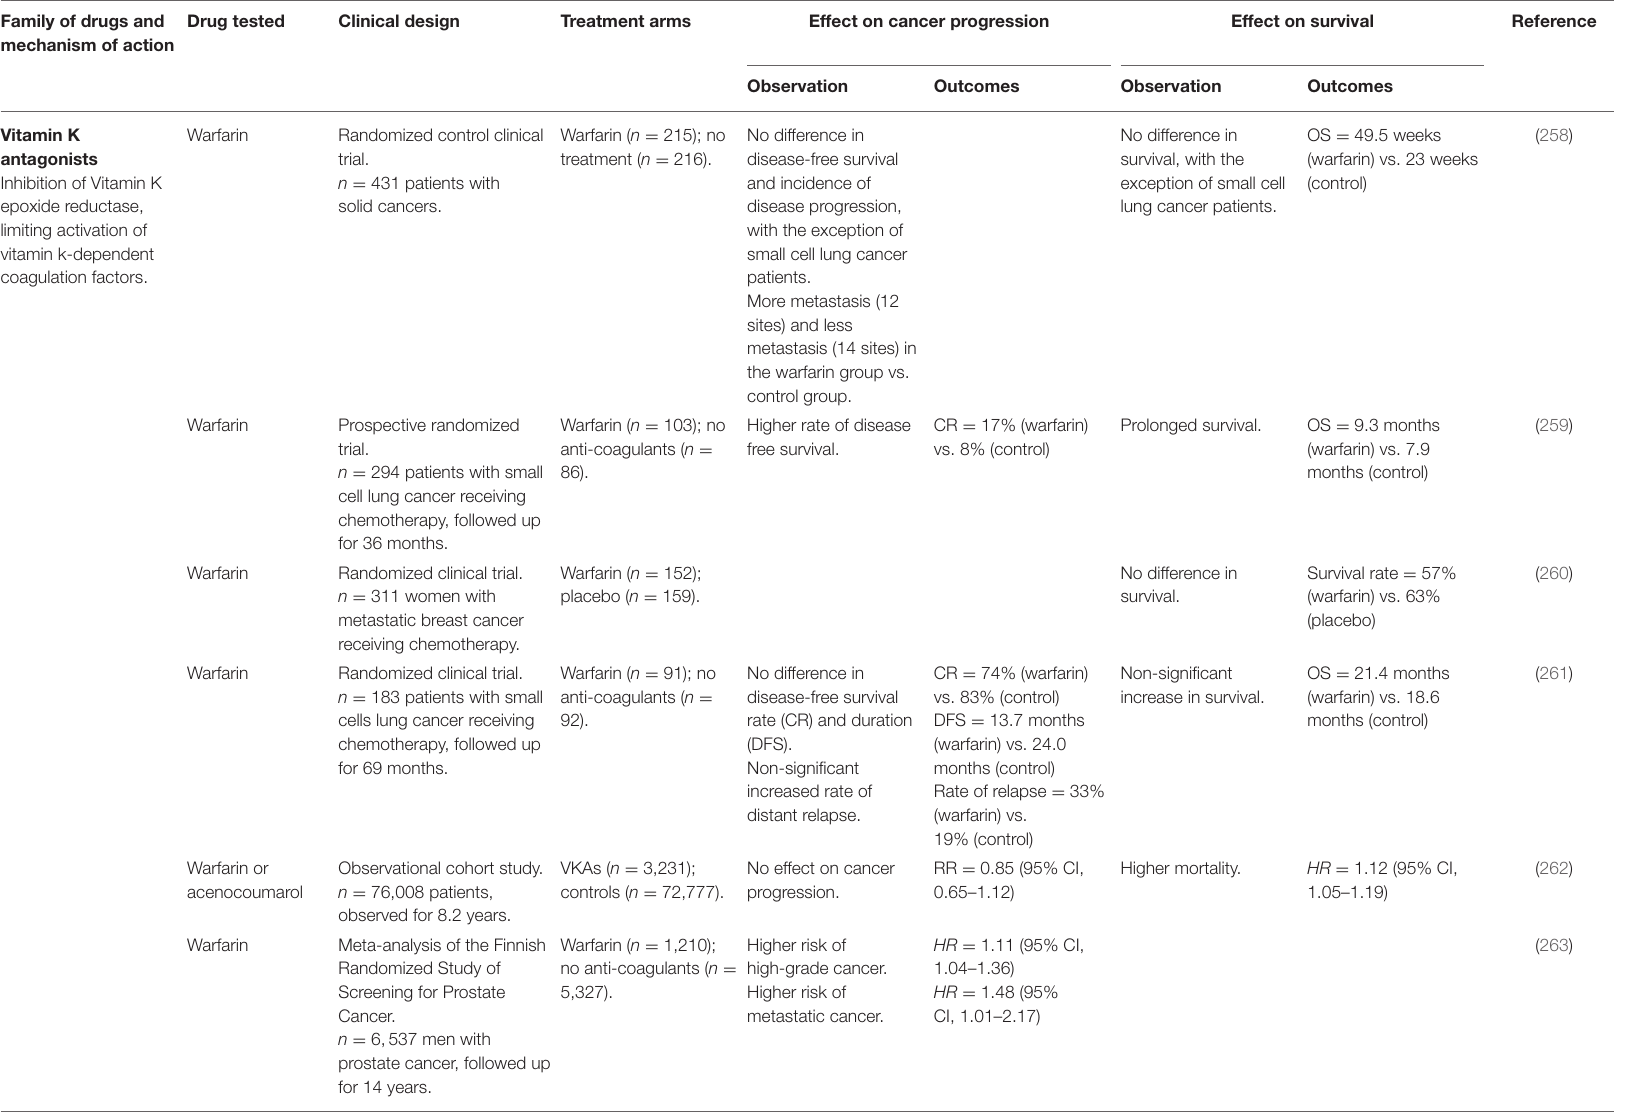
Observation Outcomes